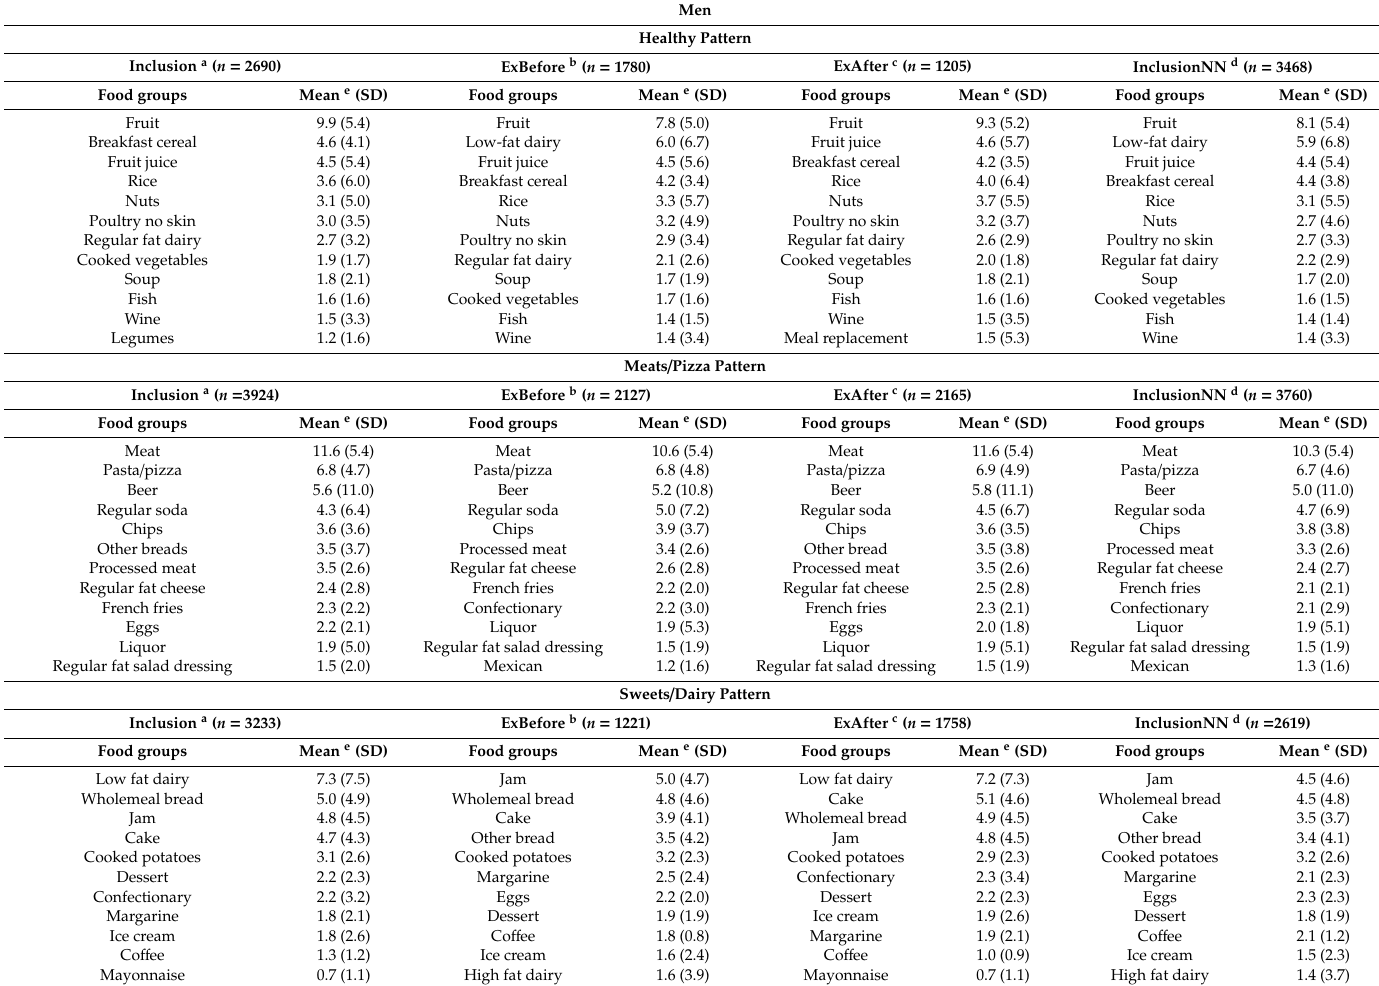
Table 3. Largest contributor based on percentage of food groups to daily total energy intake across dietary patterns and di ff erent methods to account for misreporting of energy